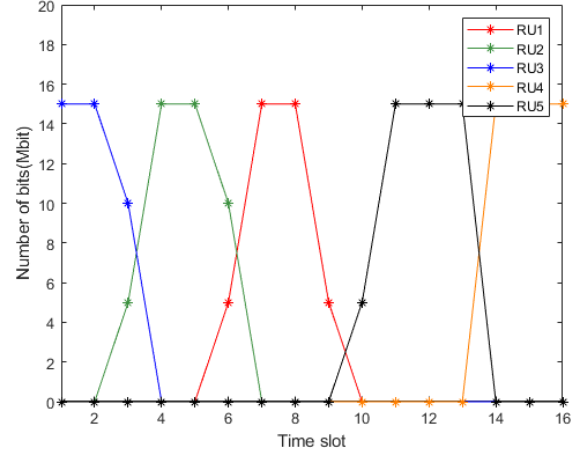
Figure 4. Bit offloading in 𝑁 time slots by an RU which selects K2 mode.